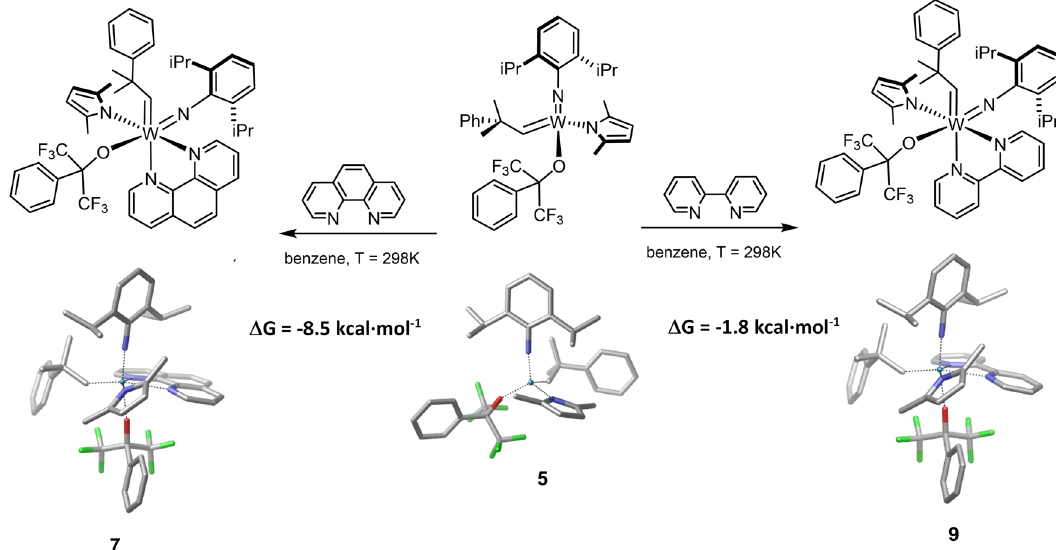
Fig. 7 DFT calculations on the Gibbs free energies of complexation of 5 by 1,10-phenanthroline and 2,2 ’ -bipyridine. Conditions: ω B97XD/Def2TZVPP// ω B97XD/Def2SVP level; in benzene as solvent (SMD, Solvation Model based on Density); at 298 K; with thermal and BSSE